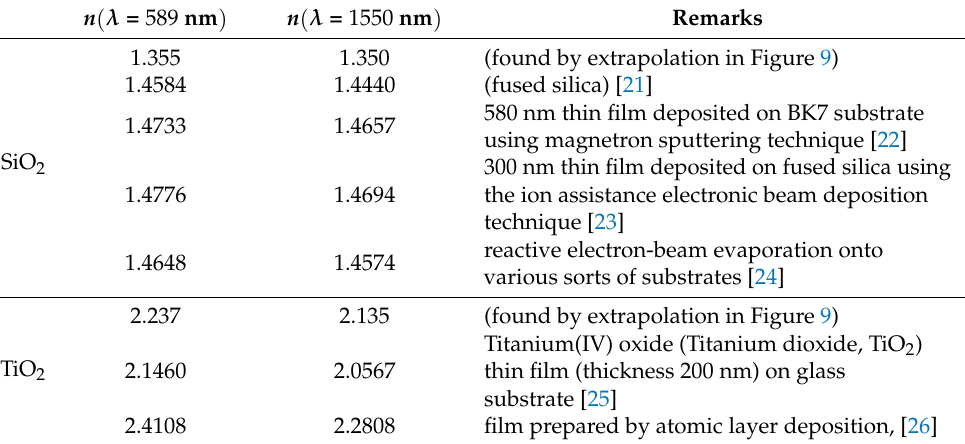
Figure 9. Dependence of refractive index on TiO 2 content. It was calculated using Sellmeier model in wavelength range between 1688 nm and 350 nm and data measured after completion of heat- ing/cooling procedures. The diagram shows chosen examples—full circles for 1550 nm (C-band), open circles for 589 nm (sodium doublet). A similar dependence occurred for other wavelengths. Table 2. Examples from the literature on the refractive index of SiO 2 and TiO 2 , measured for different types of thin